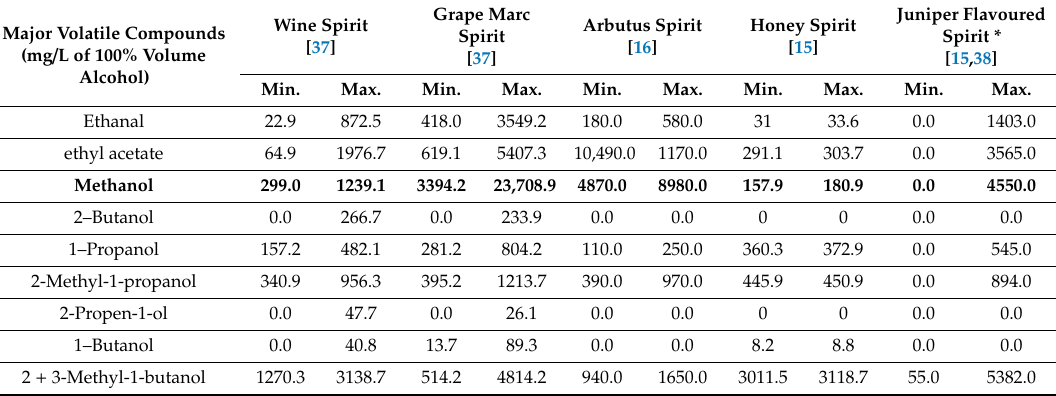
Table 1. Major volatile compounds, quantified by GC-FID in di ff erent spirits analyzed in several research works.